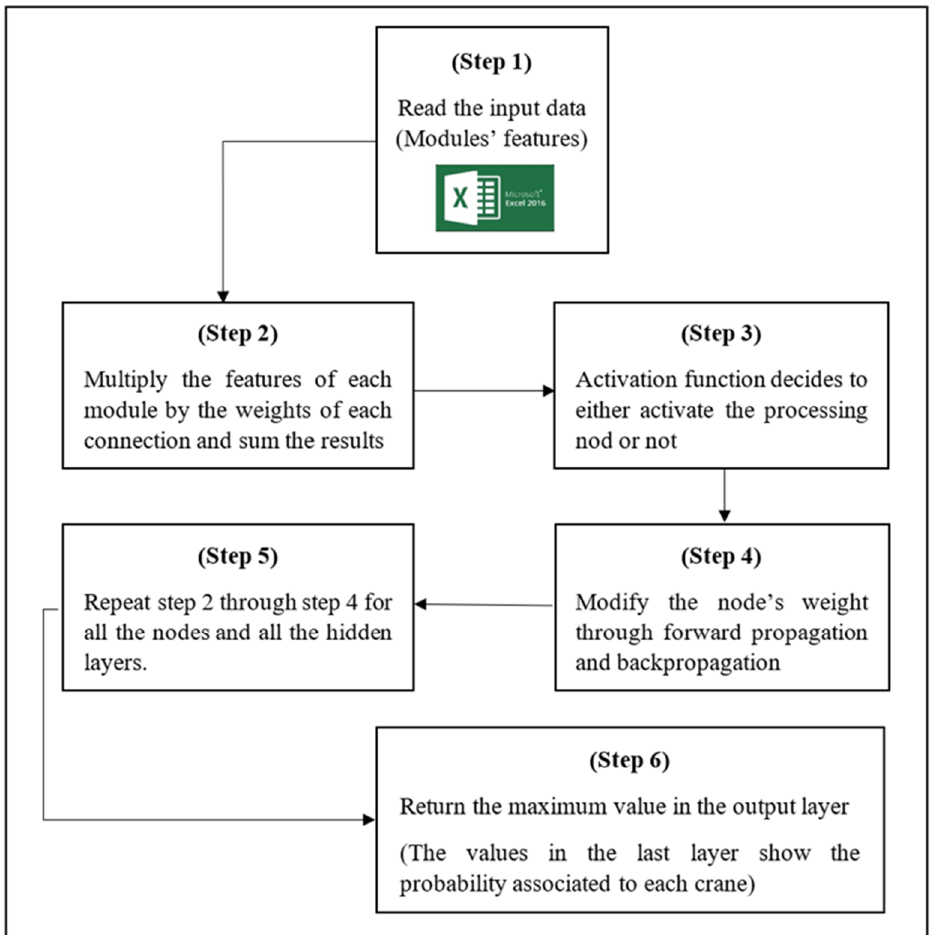
Figure 5. Neural network methodology.